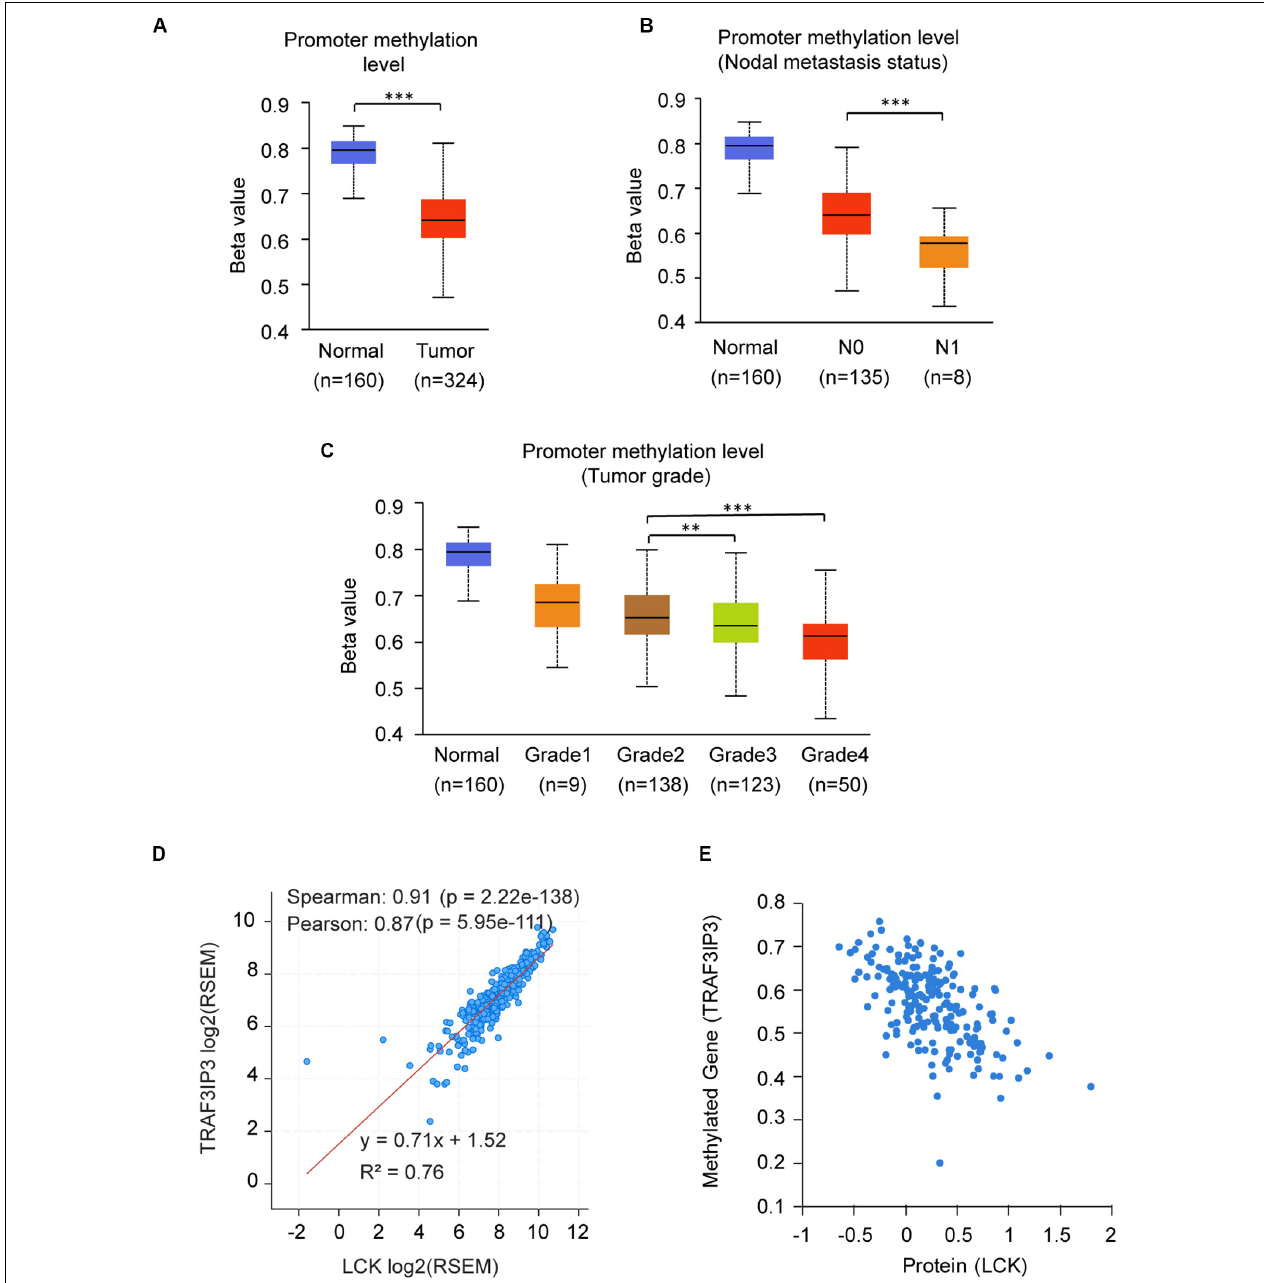
FIGURE 7 | The promoter methylation level of TRAF3IP3 is a potential regulator in KIRC. (A–C) The promoter methylation level of TRAF3IP3 in KIRC based on sample types (A) , nodal metastasis status (B) and tumor grade (C) using UALCAN. (D) The correlation of mRNA expression level between LCK and TRAF3IP3 using cBioportal. (E) The protein level of LCK was predicted to related to the methylation level of TRAF3IP3 in KIRC using TCPA. The Beta value indicates level of DNA methylation, and 0 means unmethylated, and 1 means fully methylated. The value of RNA-Seq by Expectation Maximization (RSEM) is provided by cBioportal. ** p < 0.01, *** p <